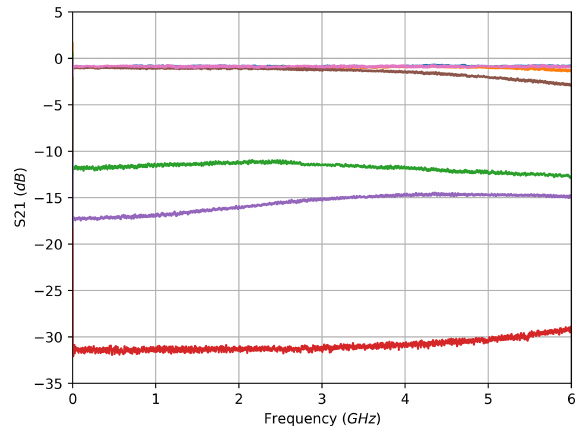
Figure 5. Electrical amplitude of S21 measurements of an FBG in reflection configuration.